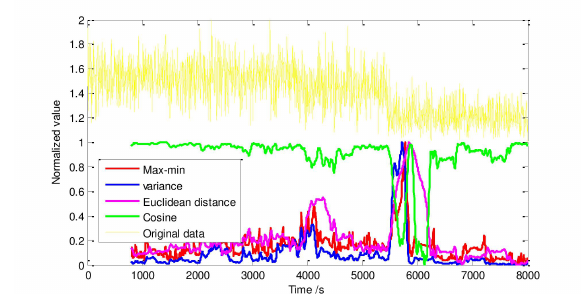
Figure 15. Detection example of strong PUE attack.